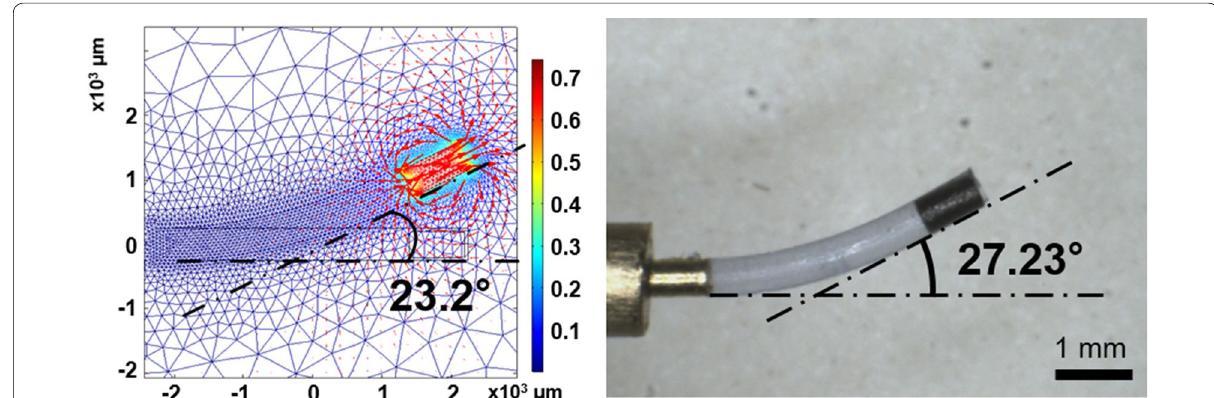
Fig. 7 Comparison between the experimental results and those of the FEM in terms of the deformation angles of the flexible microrobot actuated by a magnetic field of intensity 5 mT in the 90° direction. In the simulation panel, the x‑ and y‑axis units are millimeters and the right colored bar shows the magnetic flux density